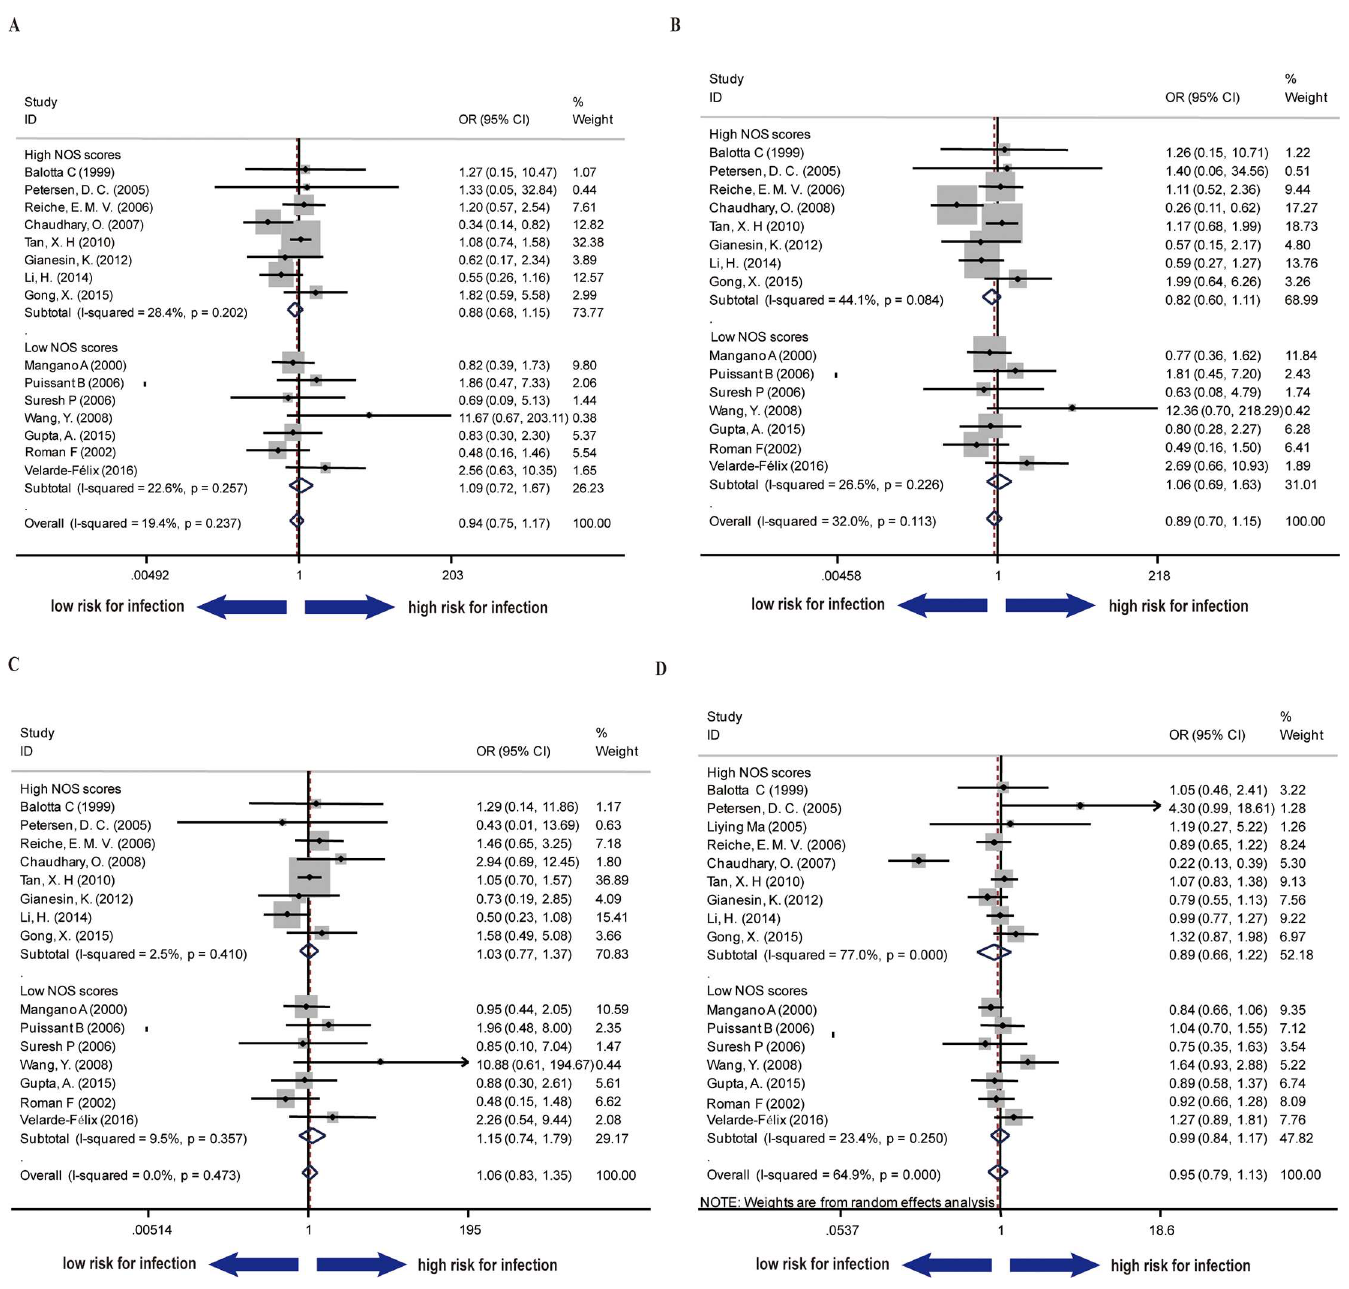
Fig 2. Forest plot of the association of SDF1-3’A and HIV susceptibility in different genetic models. (A)recessive model (B) homozygous model (C) heterozygous model (D) allele model. Studies were divided into two subgroups (High NOS scores group and Low NOS scores group) as indicated.